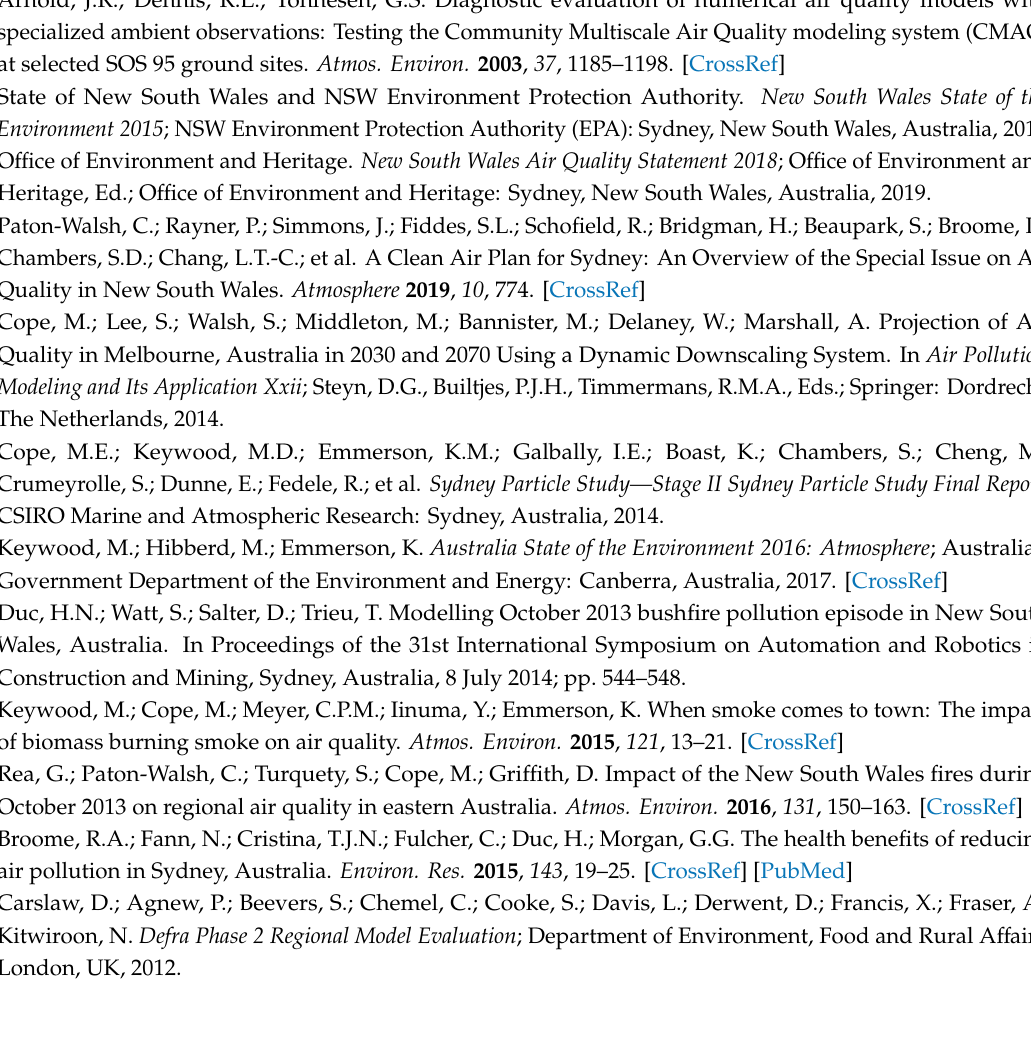
Figure A4. Box and whisker plots showing observed and modelled ammonia (NH 3 ) at each campaign site. The black dots are the average values, the box marks the first and third quartiles and the whiskers extend up to 1.5 length of the box. Outliers are open circles. No observations are available for MUMBA and no output is available from W-UM1.